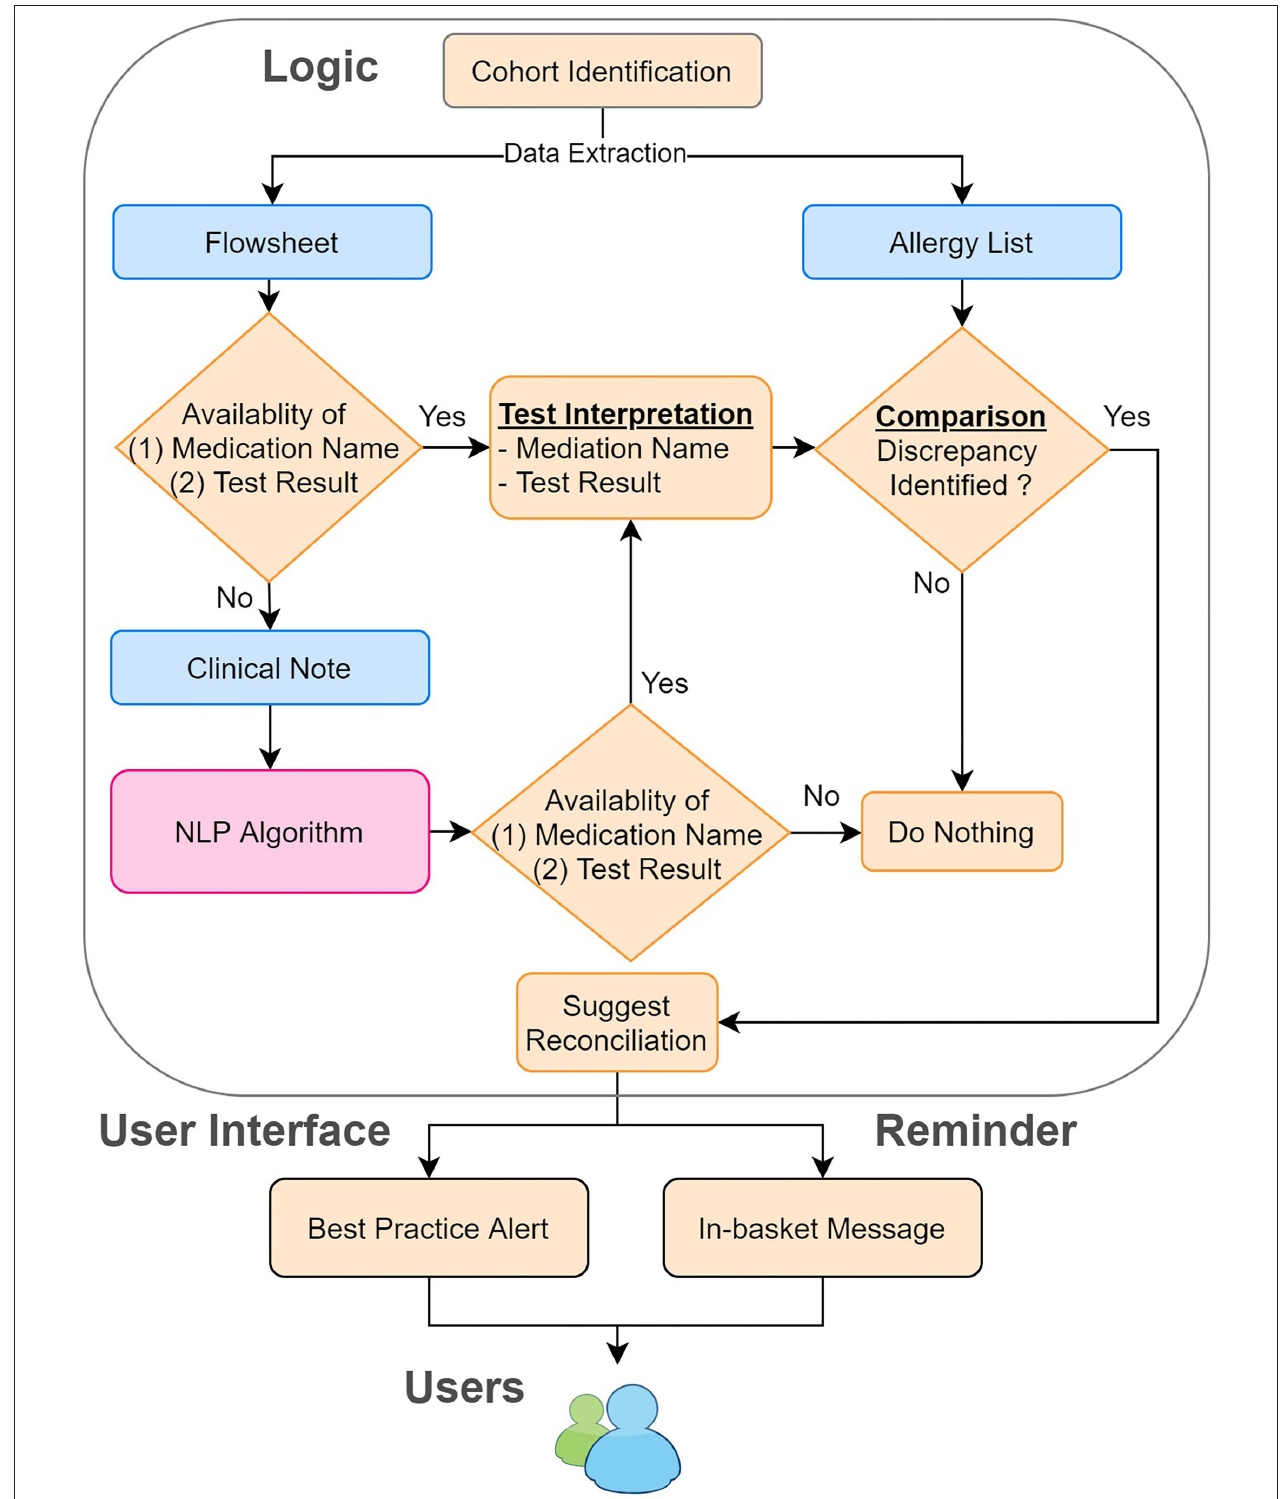
FIGURE 2 | System architecture of the reconciliation module. We combined the information derived from the flowsheets and clinical notes. We then compared this information to the allergy list to identify the discrepancies. If any discrepancies were found, we sent in-basket messages weekly to remind the physician to reconcile the allergy discrepancies by using our